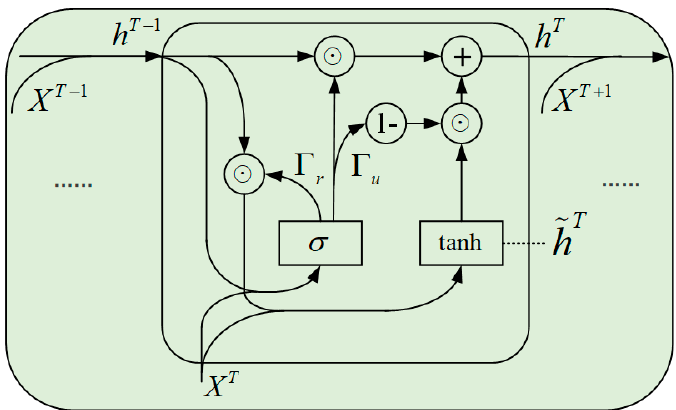
Figure 5. Model structure of the GRU.